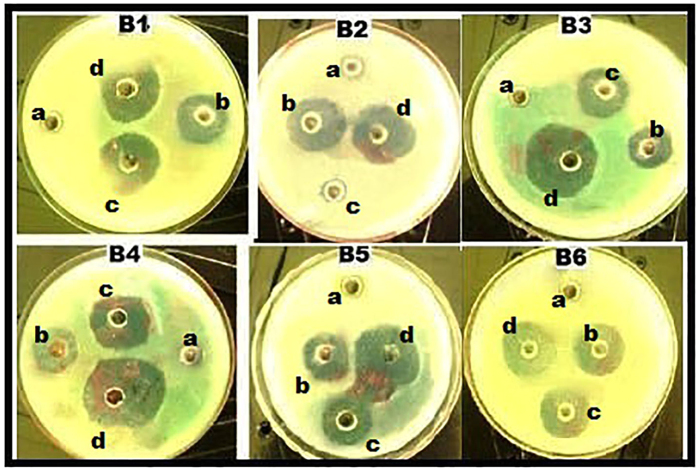
Petri plates showing the ZOI of SNPs, topical antibiotic and combinations against E. coli.B1: Cefazolin; B2: Mupirocin; B3: Gentamycin; B4: Neomycin; B5: Tetracycline; B6: Vancomycin. a: Control; b: SNP; c: Topical antibiotic; d: SNP + Topical antibiotic.